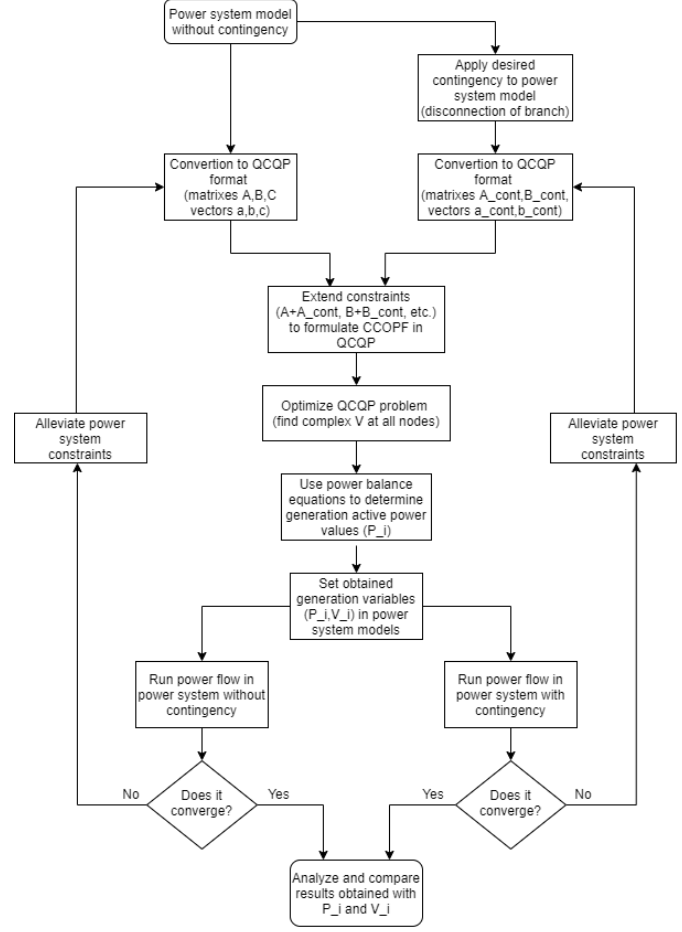
Figure 2. Flowchart of CCOPF formulation using the QCQP